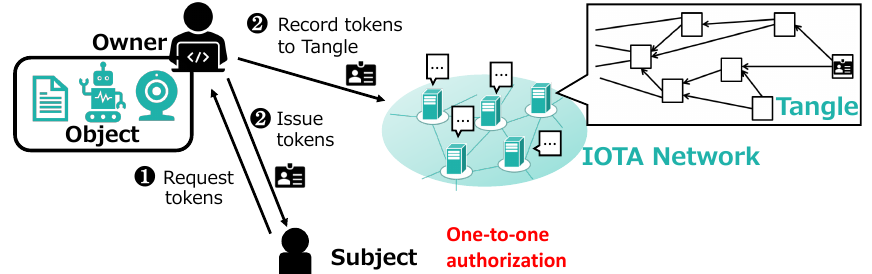
Figure 3. Access right authorization